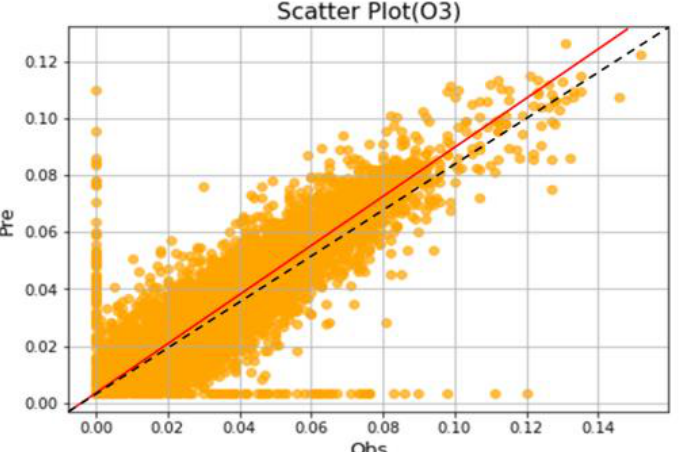
Figure 9. Comparison results of predicted ozone with observations. The regression line of observed and predicted data is indicated in red.